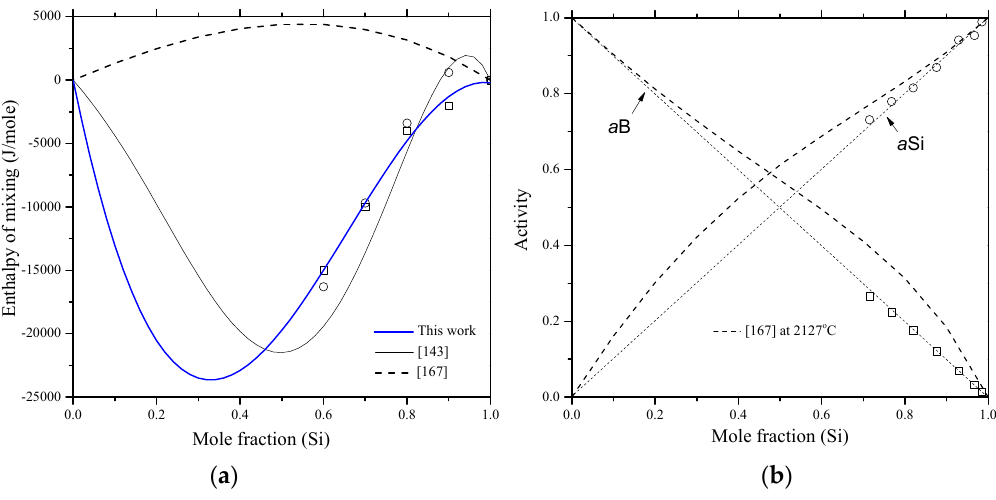
Figure 12. ( a ) Enthalpy of mixing of the B-Si liquid; —: [143]; □ : [166,168] and ○ : [150,165] at 1600 °C; -----: [167] at 2127 °C; ( b ) Average activity values of B and Si in the B-Si liquid; boron ( □ ) and silicon ( ○ ) [142] at 1577 °C; ----: [167] at 2127 °C